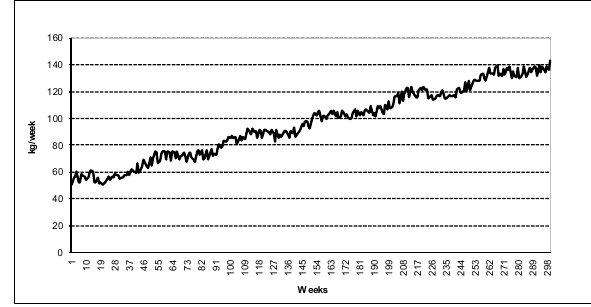
Figure 4: A run of the simulation model showing future orders over 300 weeks with trend, seasonality and